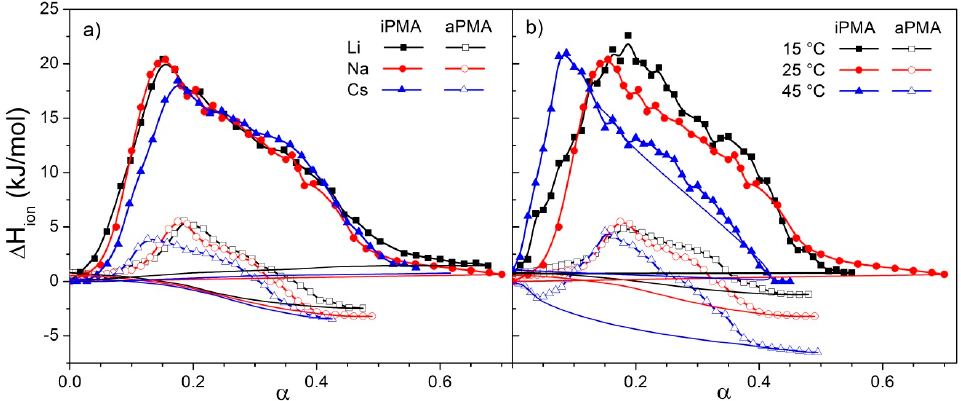
Figure 4. Enthalpies of ionization, Δ H ion , for iPMA and aPMA in aqueous 0.01 M XCl solutions as a function of the degree of ionization α ; ( a ) T = 25 °C, 0.01 M XCl (X = Li, Na, Cs); ( b ) 0.01 M NaCl, T = 15, 25, and 45 °C. The thin solid lines (with no points) are the base lines used for integration of the peaks.